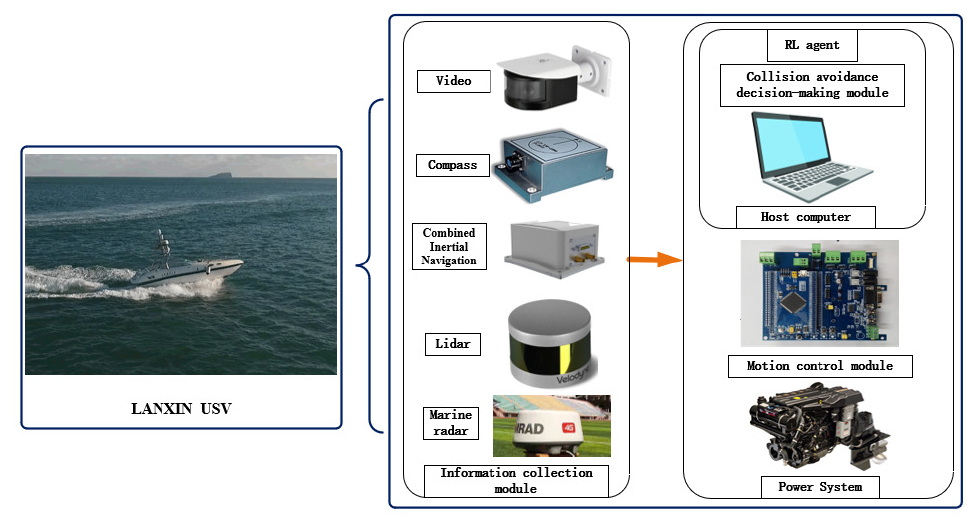
Figure 23. “Lan Xin” USV autonomous collision avoidance control